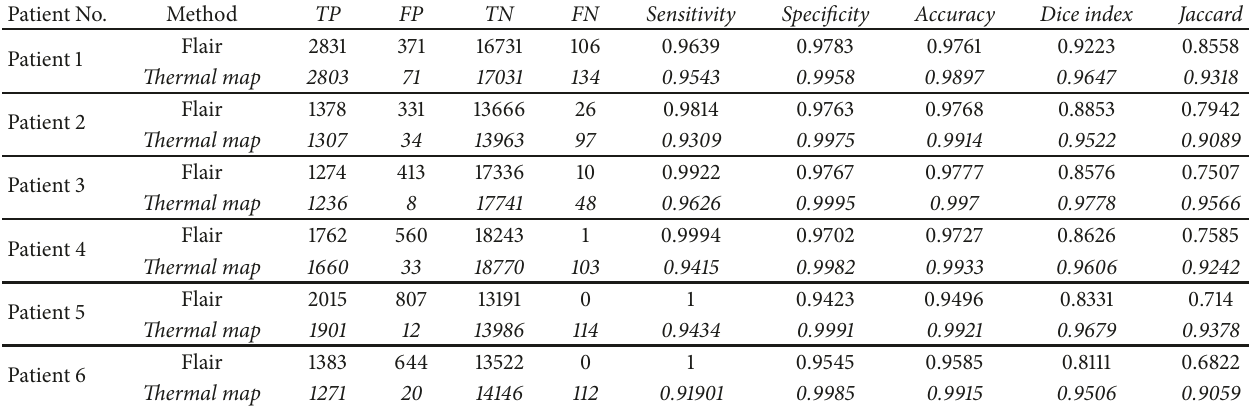
Table 6: The calculated segmentation evaluation metrics for level set method and proposed approach in BRATS Training data 2013. Patient No.